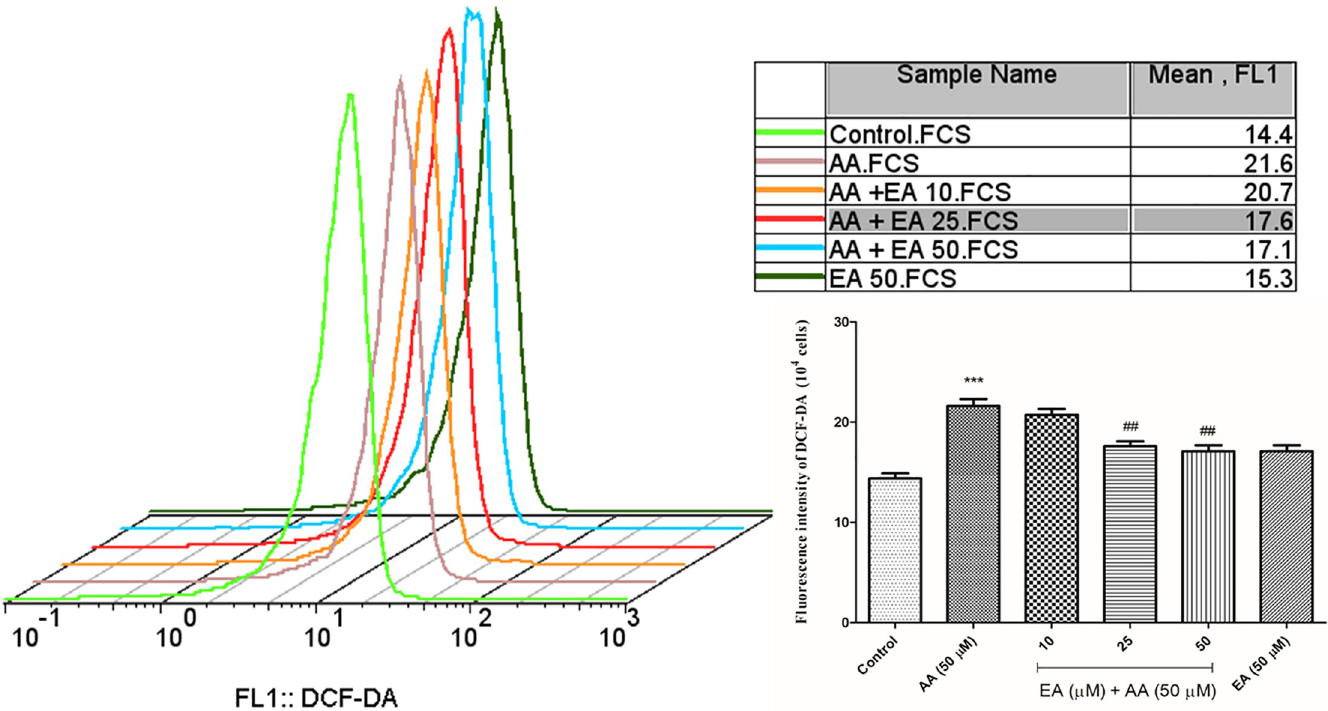
Fig 2. Ellagic acid decreases ROS formation. ROS formation was analyzed by means of fluorescence intensity of DCFH-DA following AA exposure (4 hours) in the presence or absence of EA (10, 25 and 50 μ M) in human lymphocytes. Bar graphs with statistics. Data are presented as mean ± SD, n = 3, independent experiments repeated at least 3 times, ��� p < 0.001: Control versus AA; ##p < 0.01: AA + EA versus AA-treated human lymphocytes ANOVA, Tukey’s